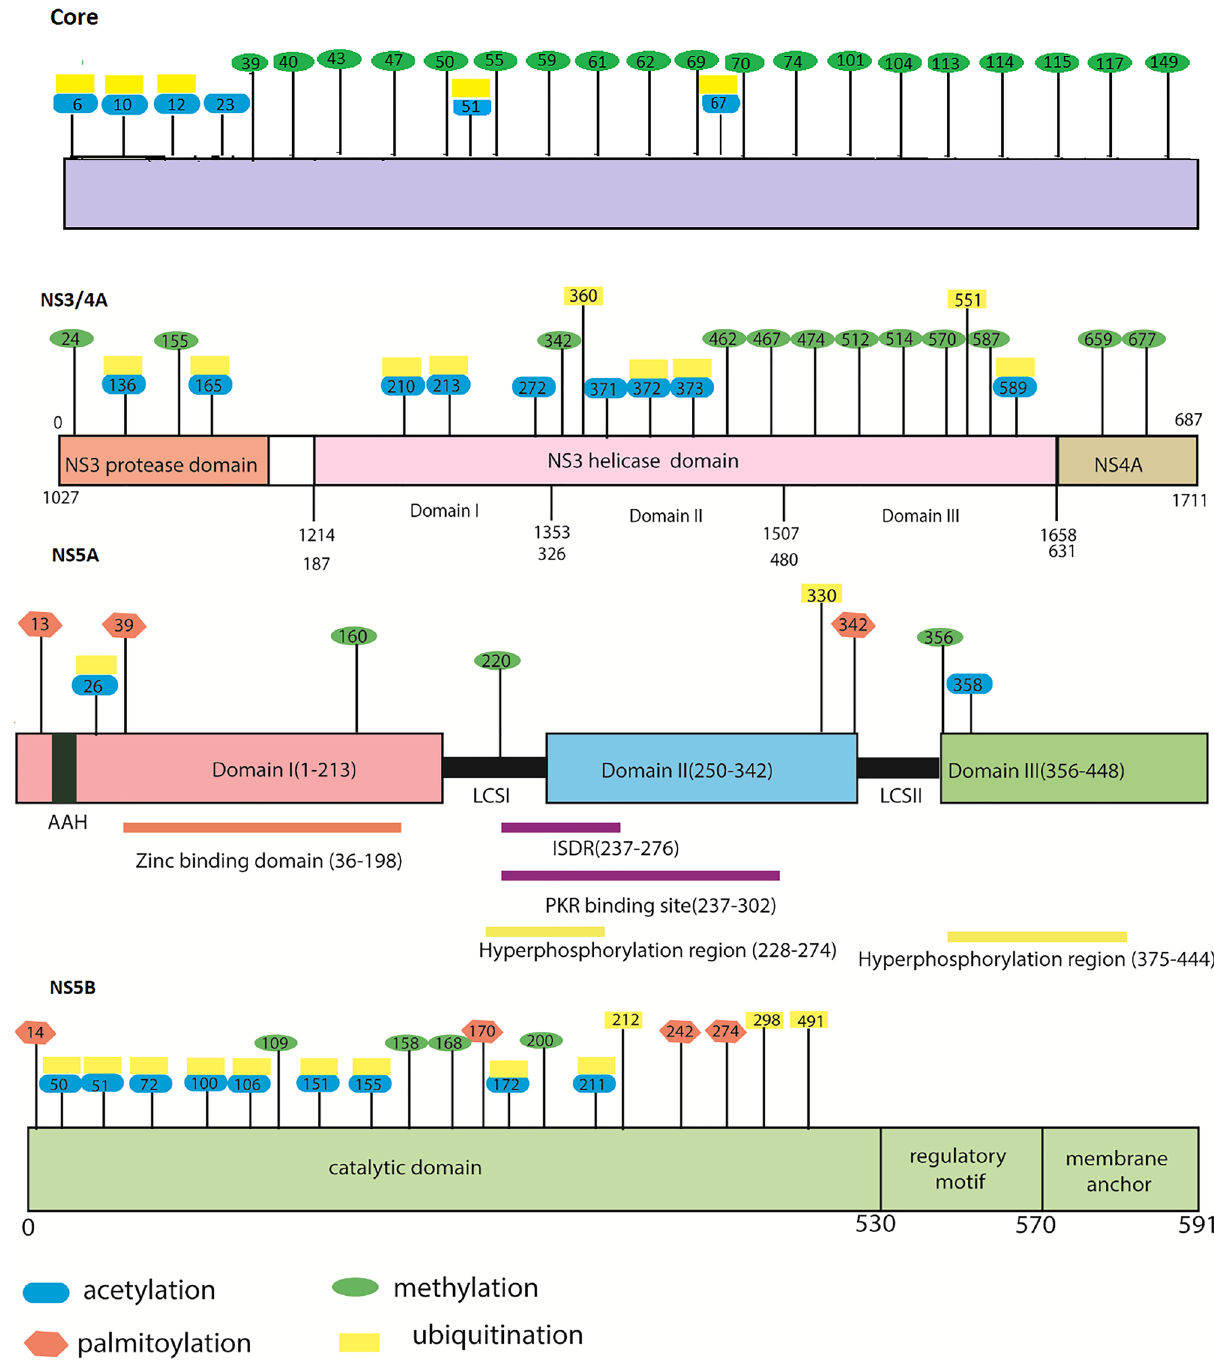
Figure 3. Schematic representation of predicted conserved acetylation, methylation, palmitoylation and ubiquitination sites within HCV NS3/4A, NS5A and NS5B. Blue oval shape represents acetylation sites, pink hexagon represents palmitoylation sites, green sphere represents methylation sites and yellow rectangular shapes are ubiquitination